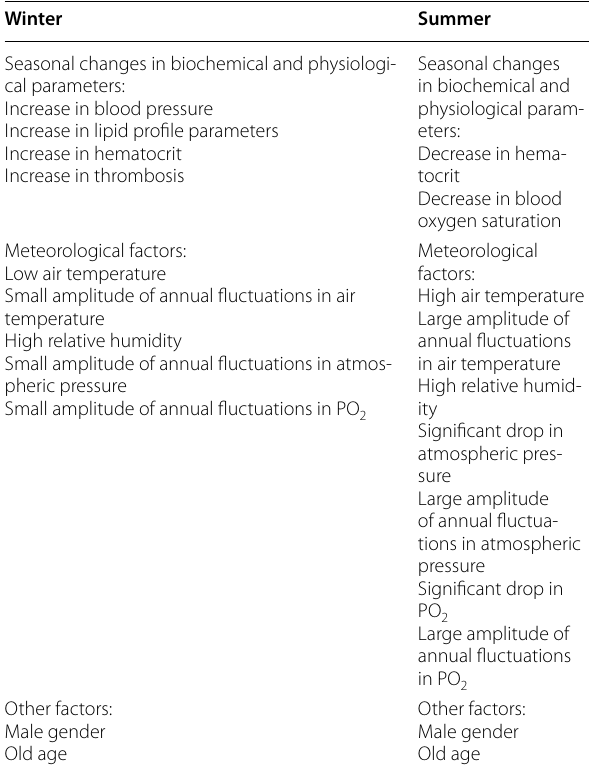
Table 4 Factors determining the seasonal risk of myocardial